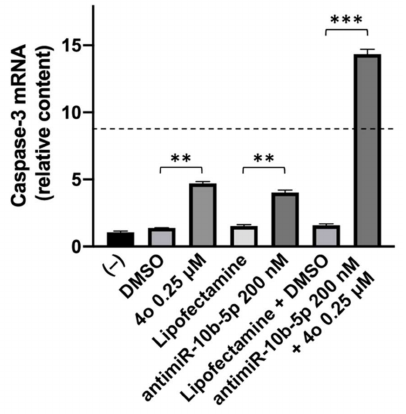
Figure 8. Effects of compound 4o and antimiR-10b-5p on Caspase-3 mRNA content in treated U251 apoptosis (data normalized on GAPDH). Similar results were obtained using RPL13A and β -actin sequences as internal controls (results shown in Supplementary Material, Figure S7). The dotted line represents the sum of the values obtained with single administrations of the compounds. p < 0.01 (**; highly significant), and p < 0.001 (***; highly